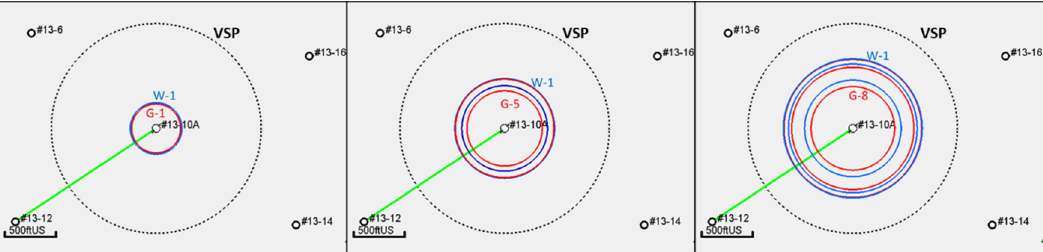
Figure 10. Illustration of hypothetical annular phase fronts at time lapse monitor surveys 1 ( left ), 2 ( center ), and 3 ( right ). The VSP image area is shown as the black dashed line.